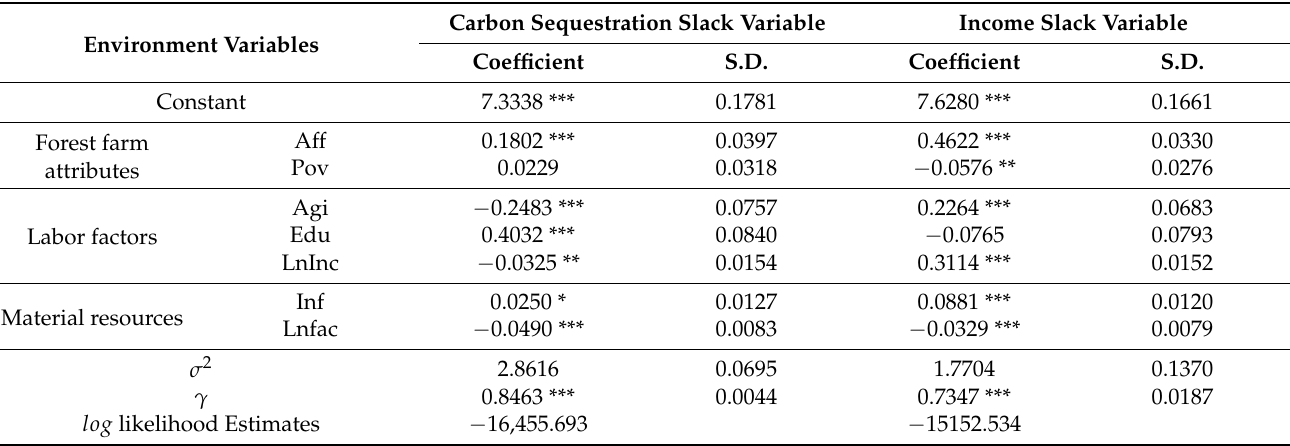
Table 3. Stage 2 panel SFA model results (the effect of external environmental